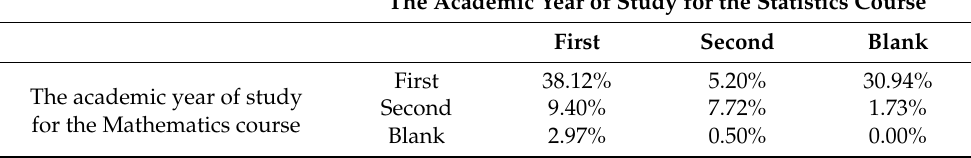
Table 4. Overview of the overall assessment in the Statistics course and the Mathematics course.